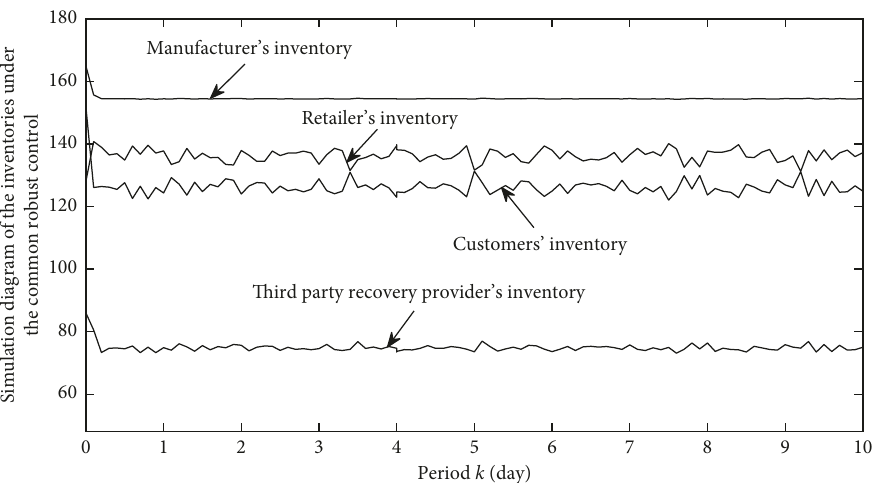
Figure 3: Simulation diagram of the inventories under CRC (unit: × 10 3 sets).